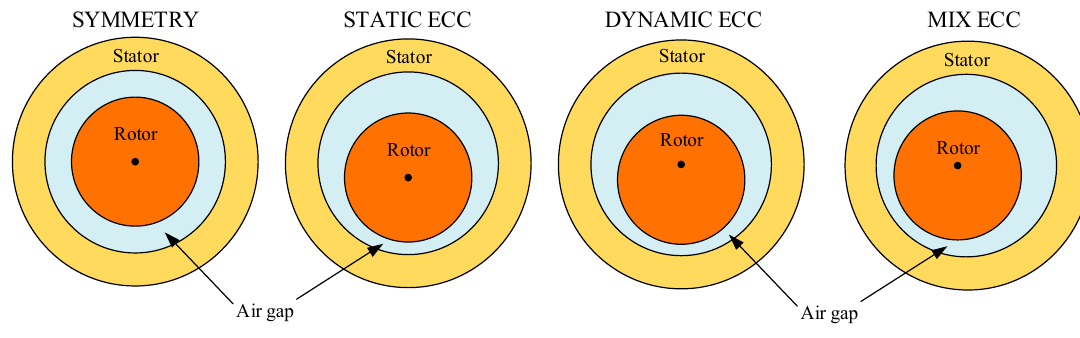
Figure 10. Modeling of eccentricity.